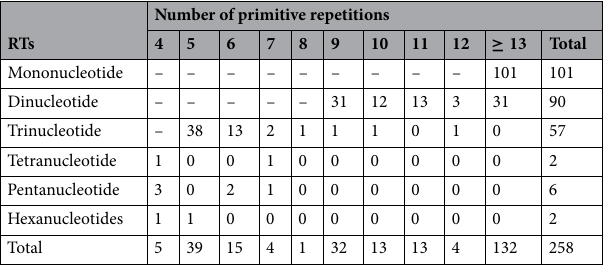
Table 2. Distribution of repeat of different